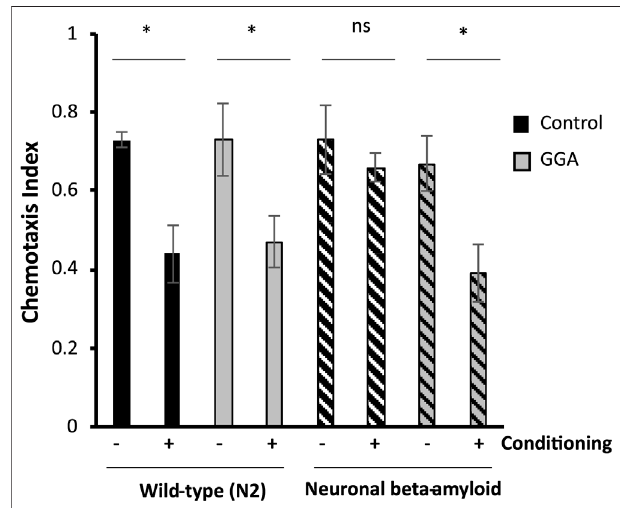
FIGURE1| GGAactivatestheHSRin C.elegans .Wild-type (N2) worms were synchronized and incubated on NGM control or 10 μ M GGA plates until day 1 of adulthood. RT-qPCR analysis showed a signi fi cant increase in basal expression of heat shock gene mRNA in worms exposed to GGA. Averages shown are from 3 biological replicates. Error bars represent SEM; * indicates p-value < 0.05 (Student ’ s t-test).